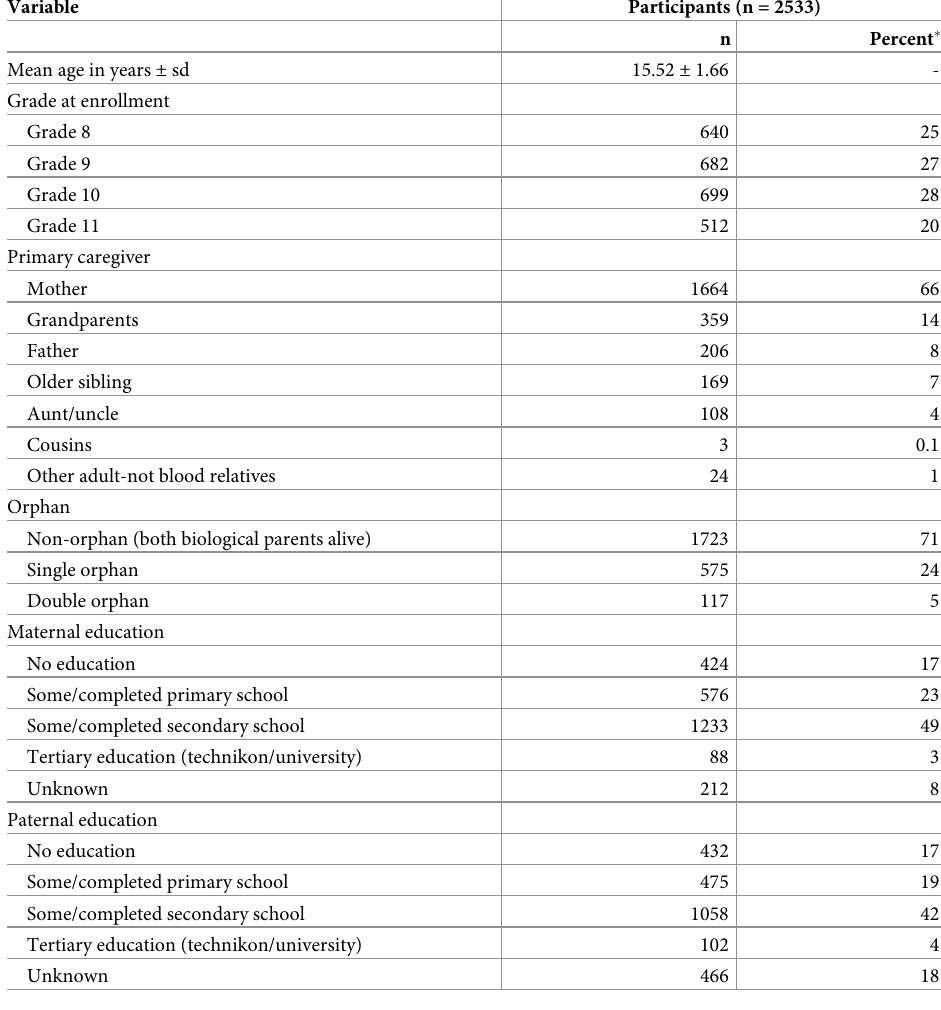
Table 2. Demographic characteristics of